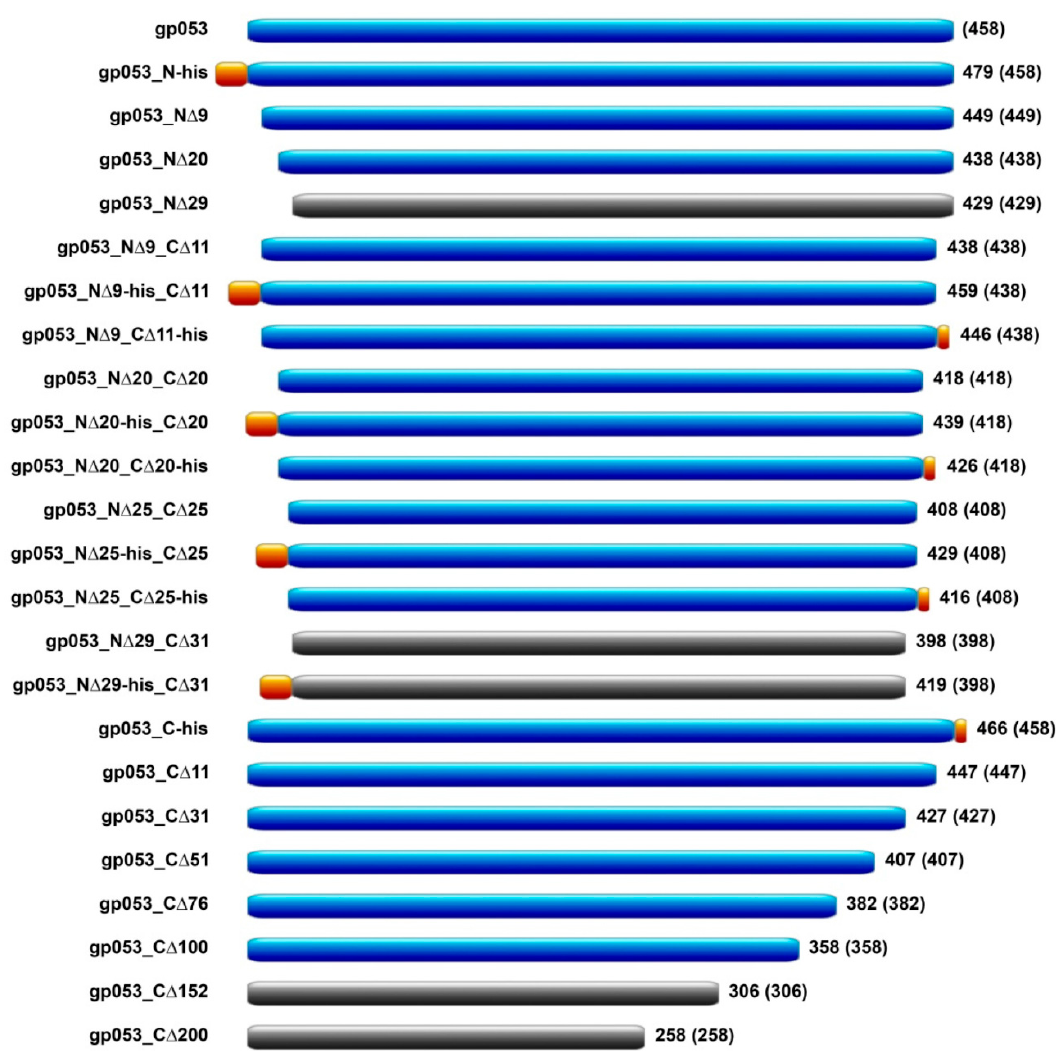
Figure 6. A schematic picture of the truncated mutants of the gp053 protein. The mutants are named (shown on the left) according to N-terminal or C-terminal mutations and the presence of His-tag. The proteins, able to polymerise into nanotubes, are shown in blue. The mutants, incapable of polymerisation, are shown in black. The His-tags are shown in orange. The size of a protein in amino acids is shown on the right, and the portion of wild-type gp053 within a construct is depicted in parenthesis.